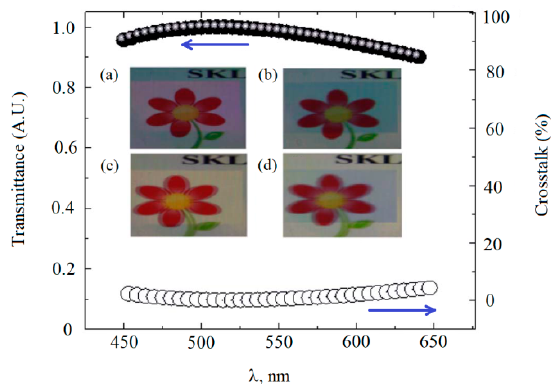
Figure 13. Wavelength dependence of light transmittance and crosstalk (a problem of coupling signals intended for a picture element on a column into other picture elements on that column and adjacent columns). Inset figures show: ( a ) 2D content with non-focusing modulation (2D mode); ( b ) 2D content with focusing modulation; ( c ) 3D content with non-focusing modulation; ( d ) 3D content with focusing modulation.